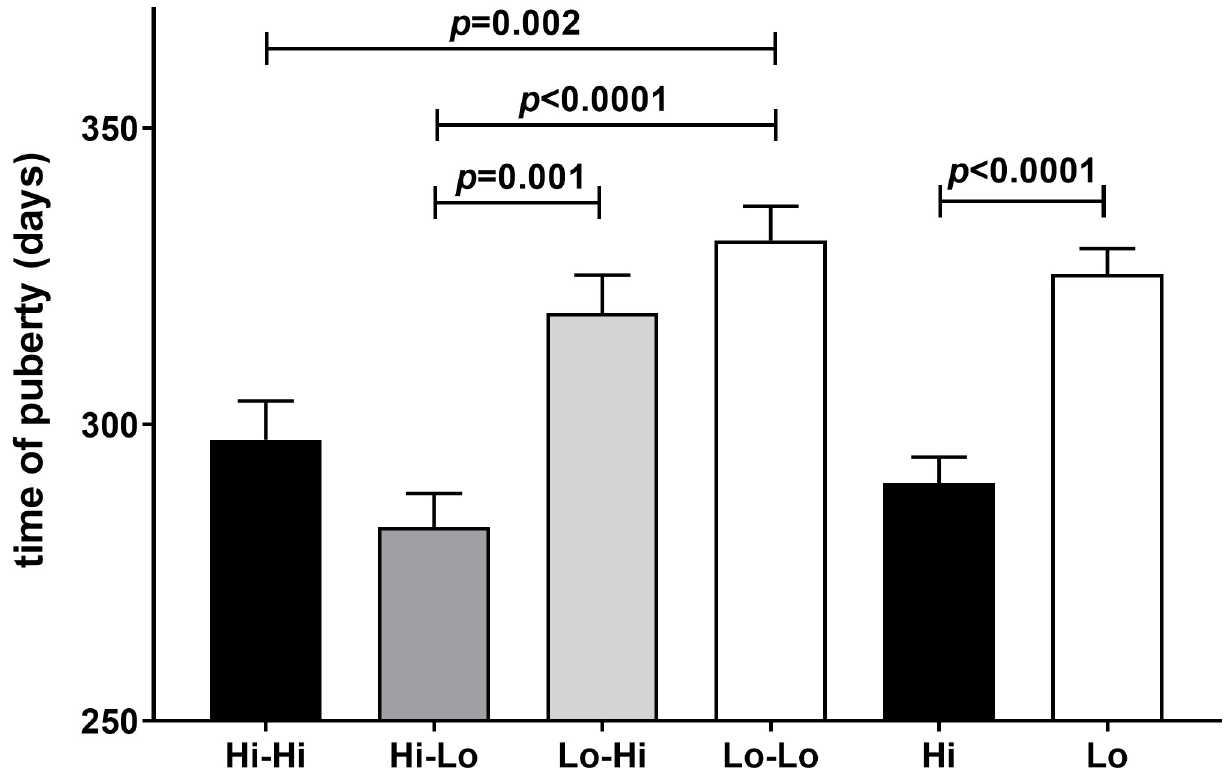
Fig 6. Timing of puberty (days) segregated by nutritional regimen. Puberty is measured as first appearance in the ejaculate of > 50 million sperm and > 10% forward motility, segregated by nutritional regimen as in Fig 2. Probability of a significant regression is indicated as p value.